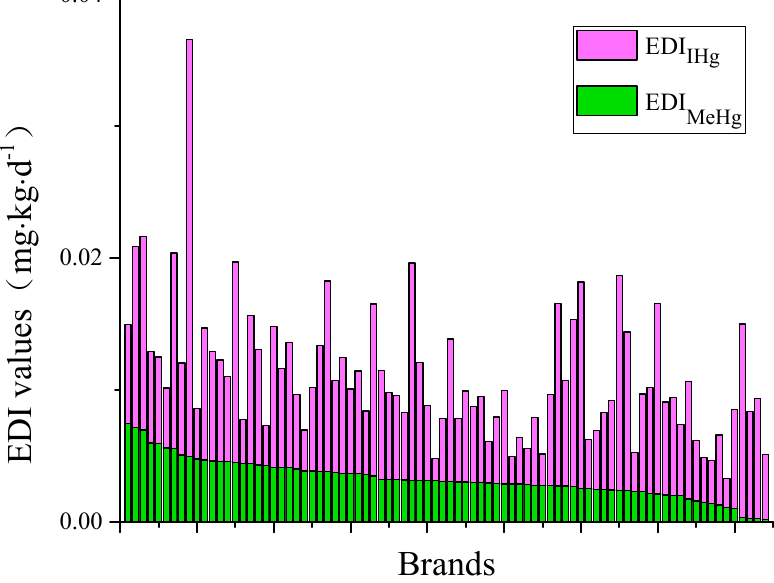
Figure 4. The EDI (estimated daily intakes) value from the different brands of rice.